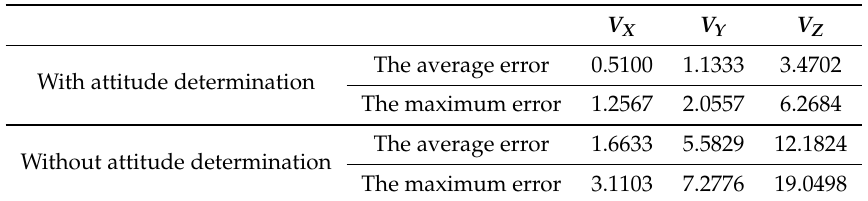
Table 3. Velocity accuracy data statistics (unit: